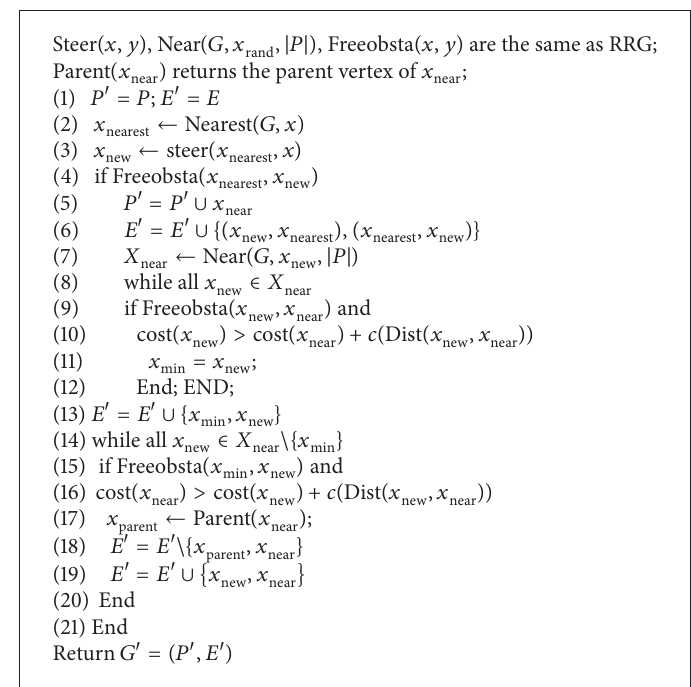
Algorithm 3: Explore